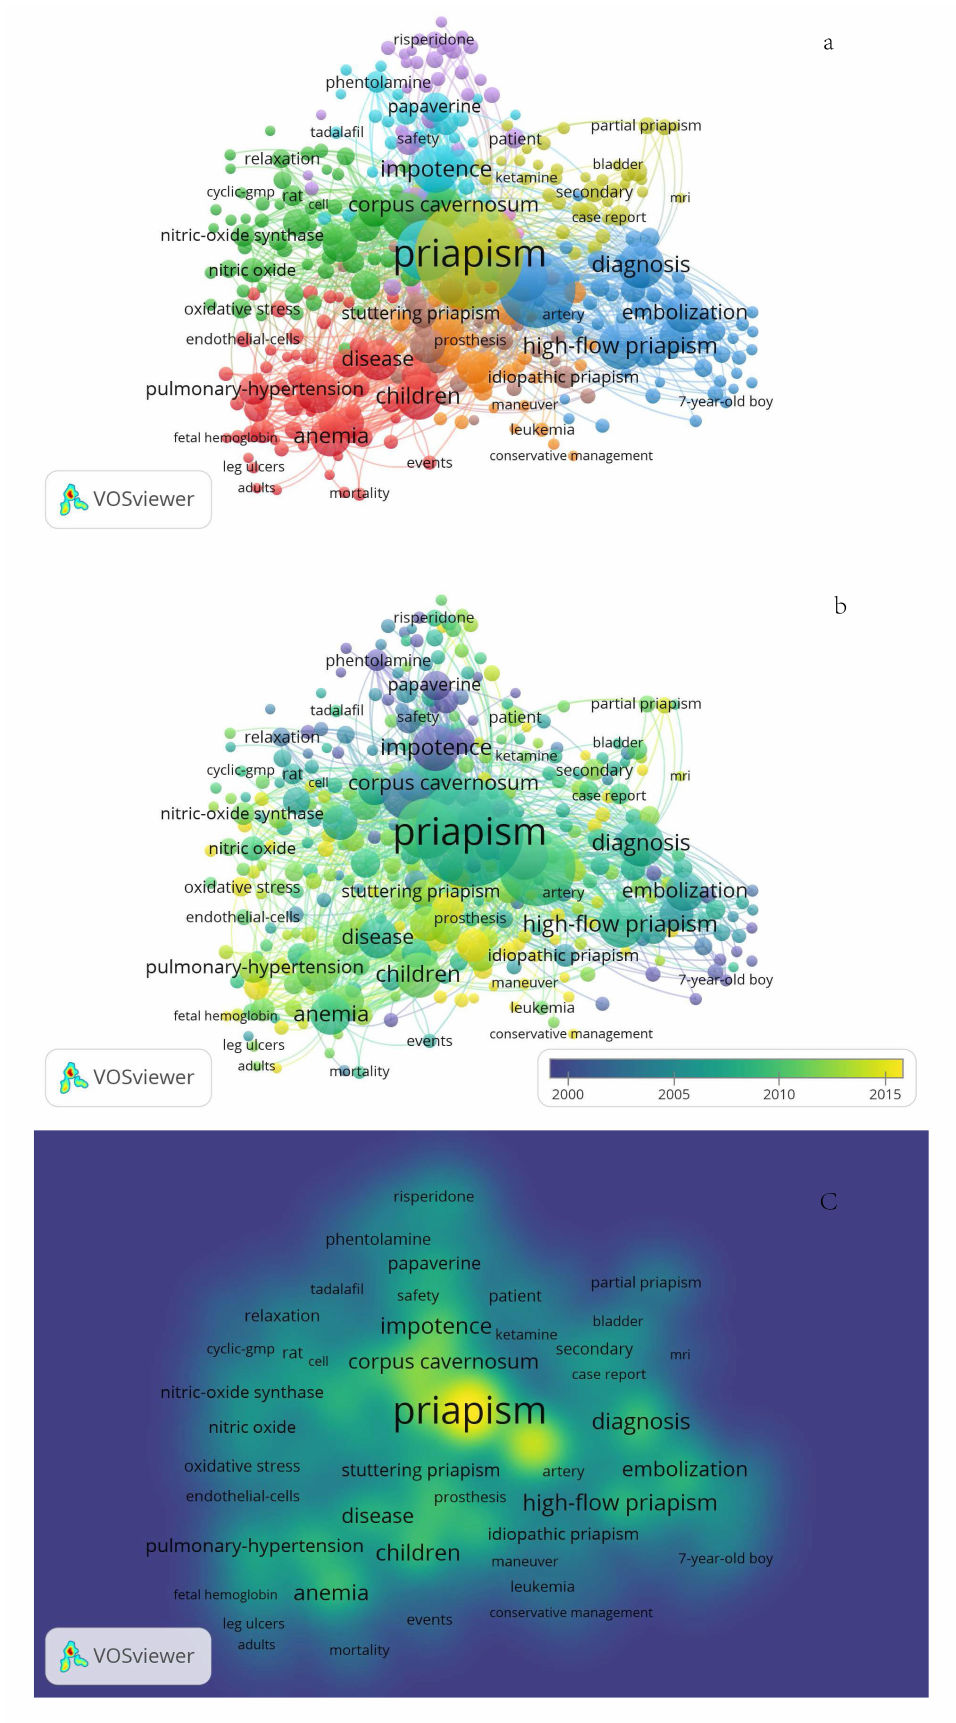
FIGURE 5. The font size of each key word represents the number of publications. The thickness of the lines indicates the strength of the connection. a, the keywords collaboration network of research on priapism, and the same color represents the same cluster. b, different colors inside the circle represent different time intervals. c, the brighter the color, the more publications about